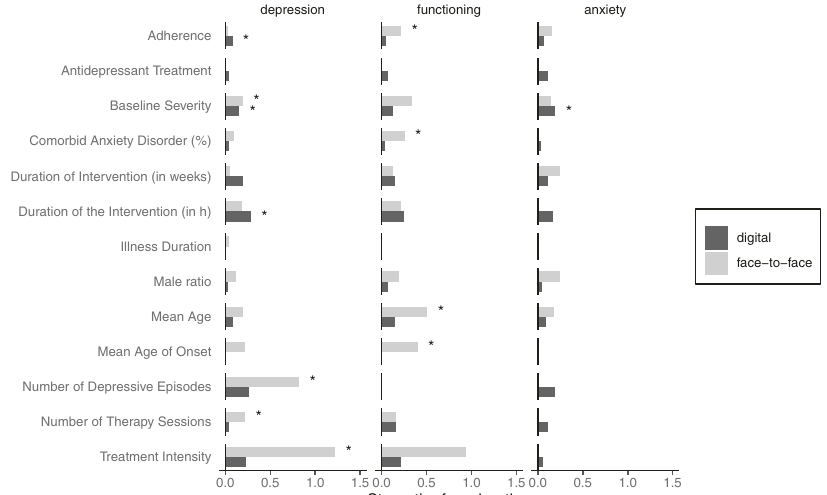
Fig. 4 Results of the moderating analysis on depression symptoms, psychosocial functioning and anxiety symptoms. Strength of moderation was quanti fi ed by the beta-coef fi cient of the meta-analytic moderation model and moderation effects are plotted as absolute and sqrt values for better visualization. “ * ” indicates signi fi cant moderation effects ( p < 0.05) in the meta-analytic